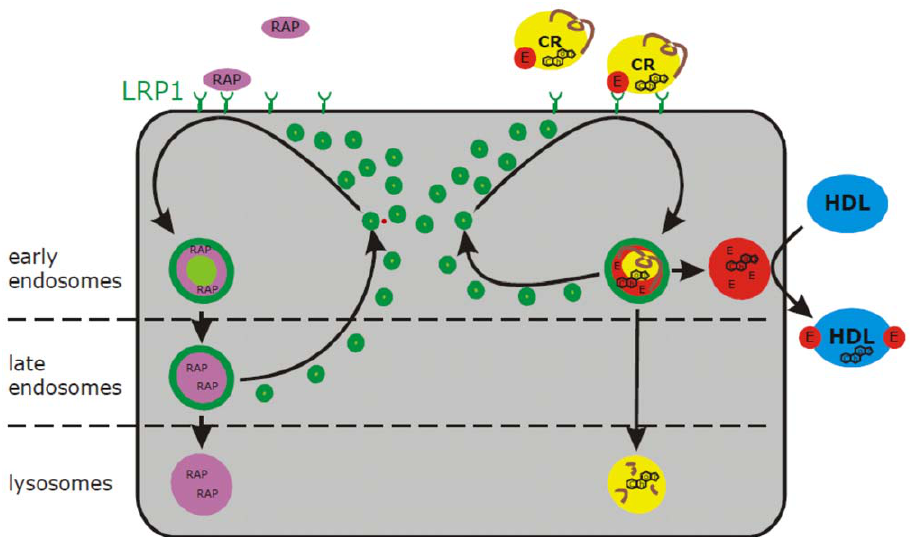
Figure 9. Model of LRP1-dependent uptake and apoE recycling. Left: RAP is internalized by LRP1, remains associated with the receptor in early endosomes and dissociates in late endosomes, from which LRP1 recycles back to the plasma membrane. RAP is degraded in the lysosome. Right: apoE-TRL are taken up by LRP1 via apoE and disintegrate in early endosomes. While apoE remains in early endosomes and LRP1 recycles back to the PM, the core particle is targeted to the lysosome. Upon stimulation with HDL, apoE separates from LRP1 and re-associates with HDL in early endosomes prior to re-secretion. See text for further details.